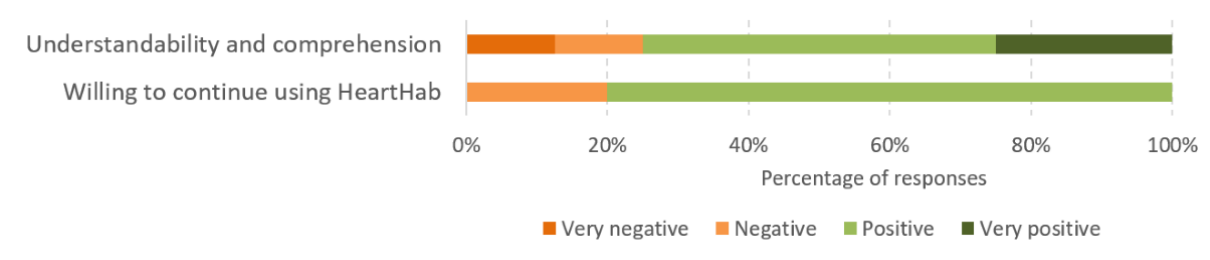
Figure 7. Results of sentiment analysis using NVIVO on patients' motivation to continue using HeartHab and the impact of the app on improving their overall understandability and